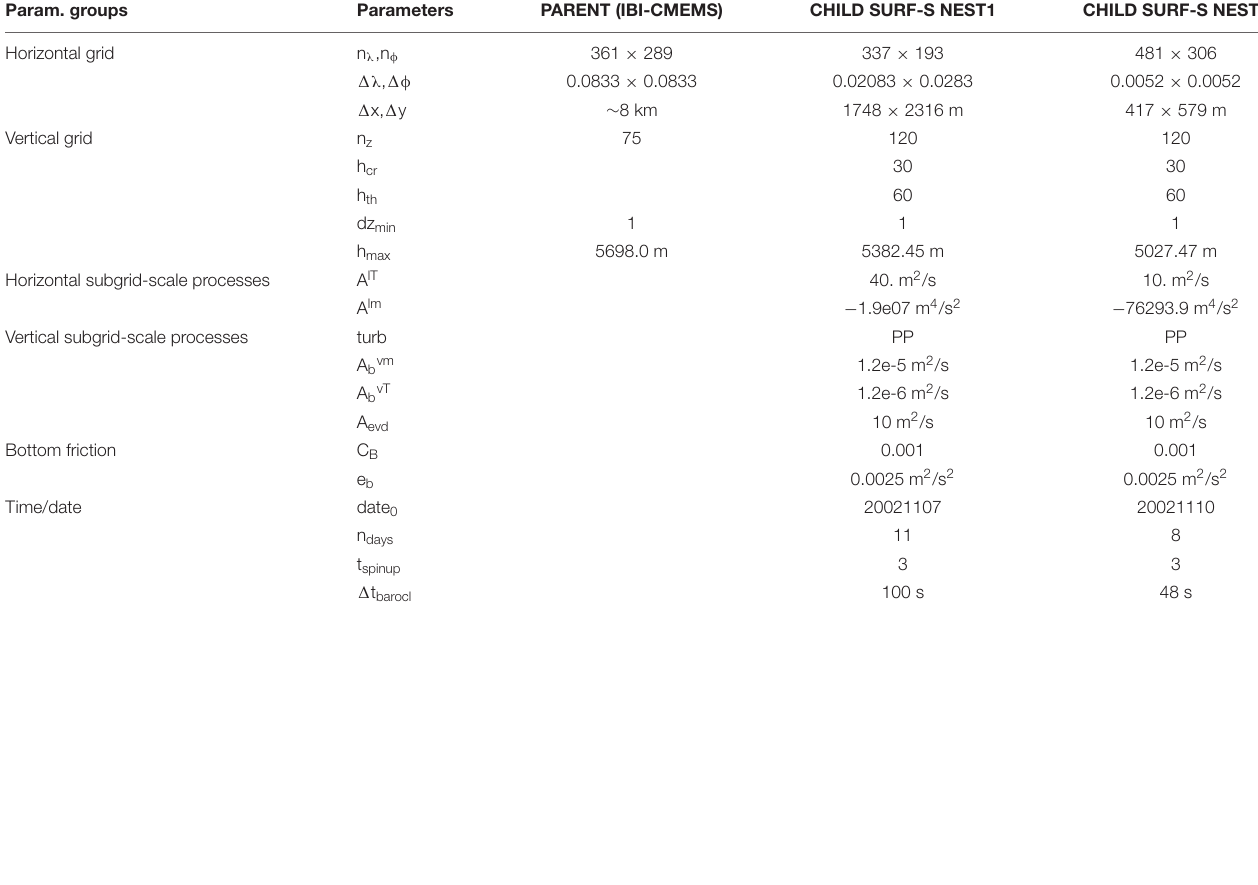
TABLE A4 | Model parameters characterizing the Prestige accident study case. Param.